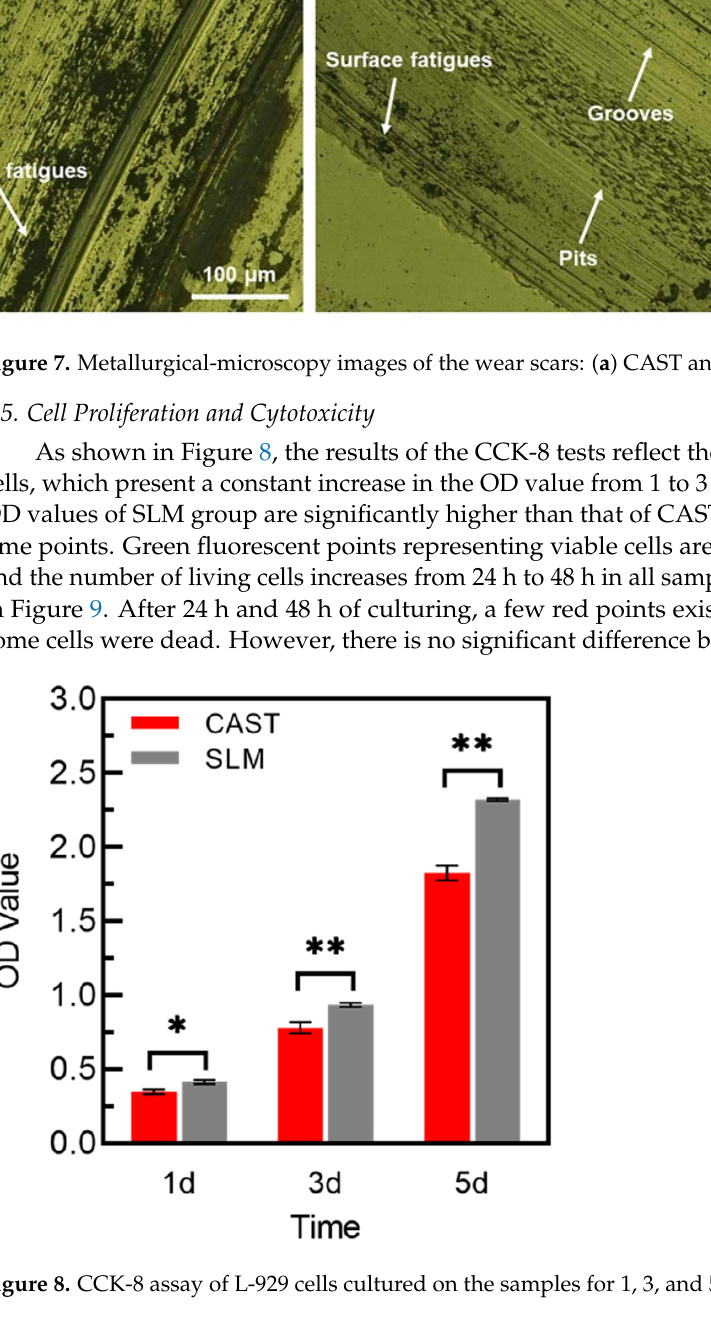
Figure 8. CCK-8 assay of L-929 cells cultured on the samples for 1, 3, and 5 d (* p < 0.05, ** p < 0.01). Figure 9. Fluorescence images of L-929 cells cultured on the samples for 24 h ( a , b , e , f ) and 48 h ( c , d , g , h ) via Live/Dead staining, indicating live cells (green) and dead ones (red): ( a – d ) CAST and ( e – h ) SLM.